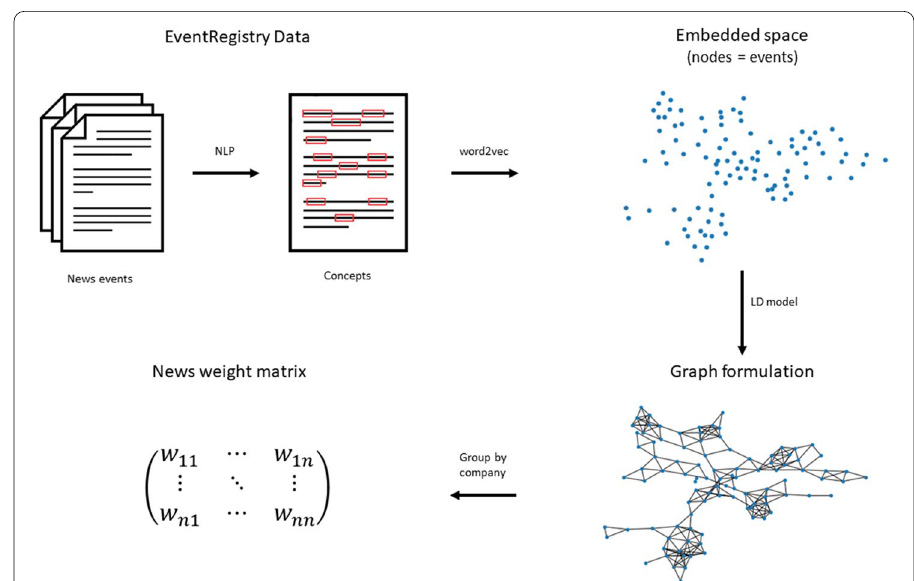
Fig. 2 Pipeline of the proposed methodology for obtaining company relationships from news